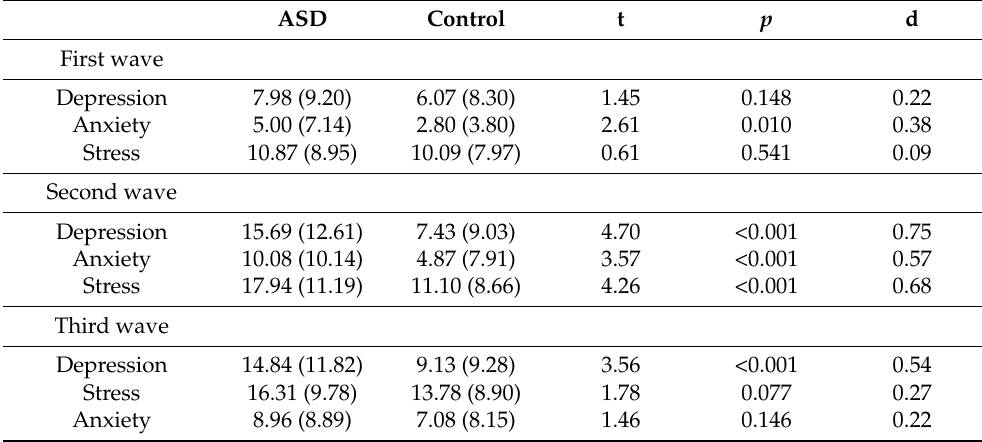
Table 2. Differences in depression, anxiety and stress between the parents of children with ASD and parents of neurotypical children.